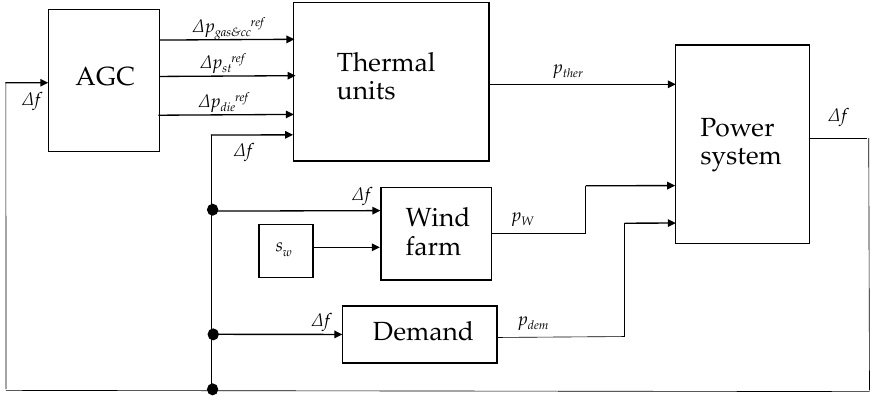
Figure 3. Block diagram of the frequency analysis